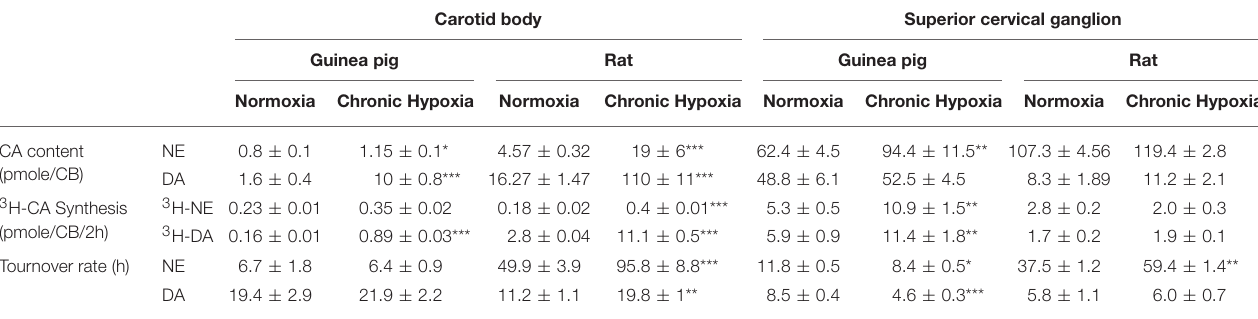
TABLE 2 | Content, synthesis and turnover rate of CA from CB and superior cervical ganglion (SCG) from guinea pigs and rats in normoxia and chronic hypoxia conditions. Carotid body Superior cervical ganglion Guinea pig Rat Guinea pig